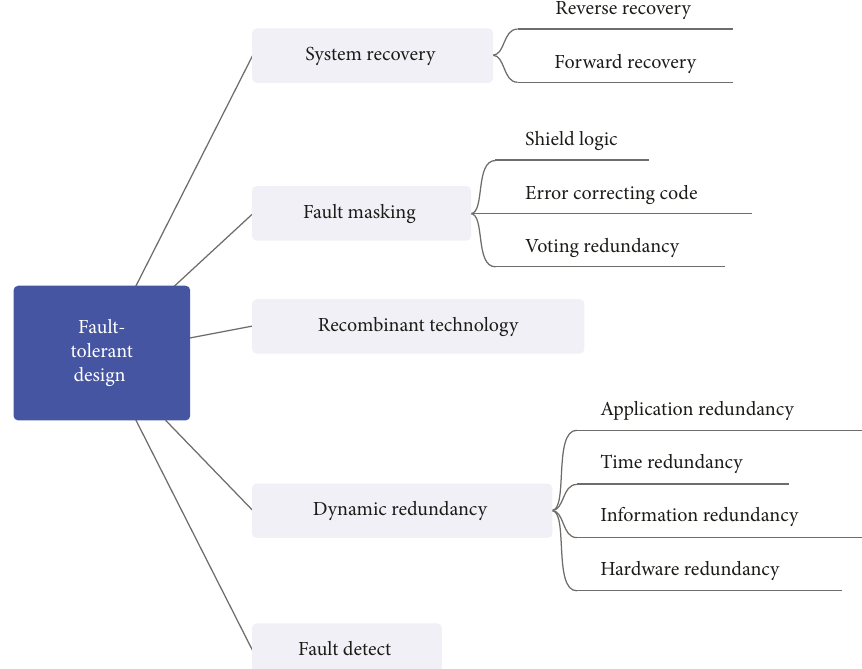
Figure 7: Fault-tolerant design method diagram.